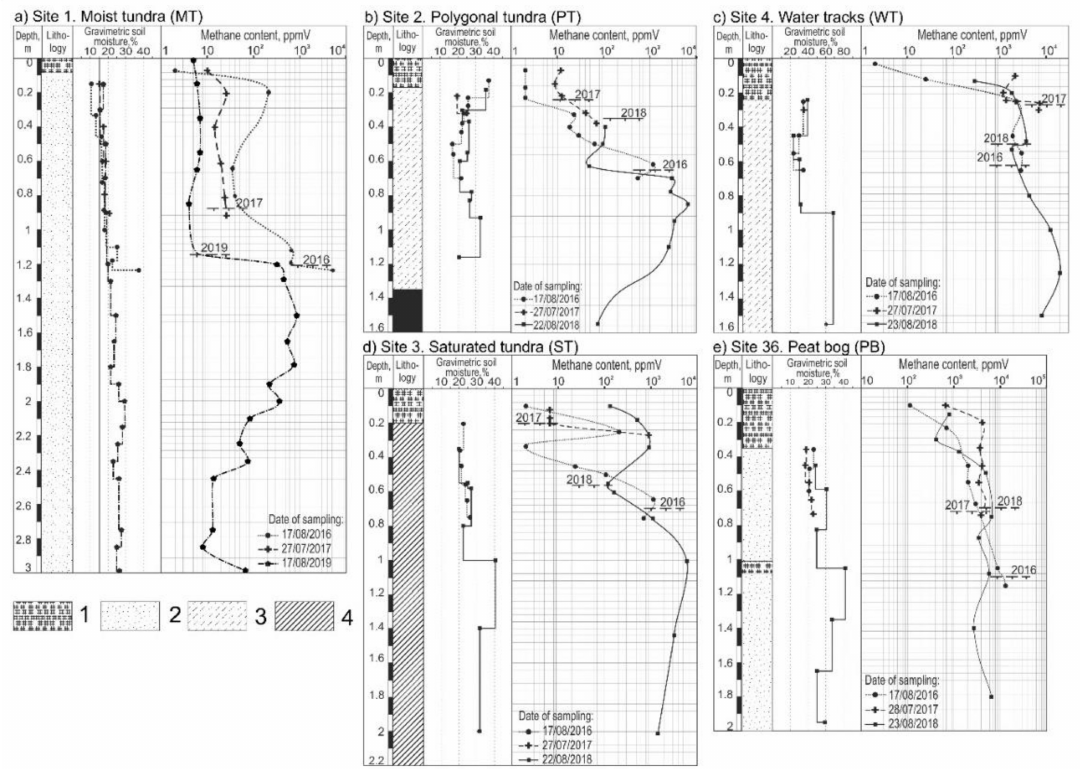
Figure 7. Methane contents and gravimetric moisture contents of soils of the active layer and transition zone of the upper permafrost in dominant landscapes of the Marre-Sale study area: ( a ) moist tundra (MT), ( b ) polygonal tundra (PT), ( c ) water tracks (WT), ( d ) saturated tundra (ST), ( e ) peat bog